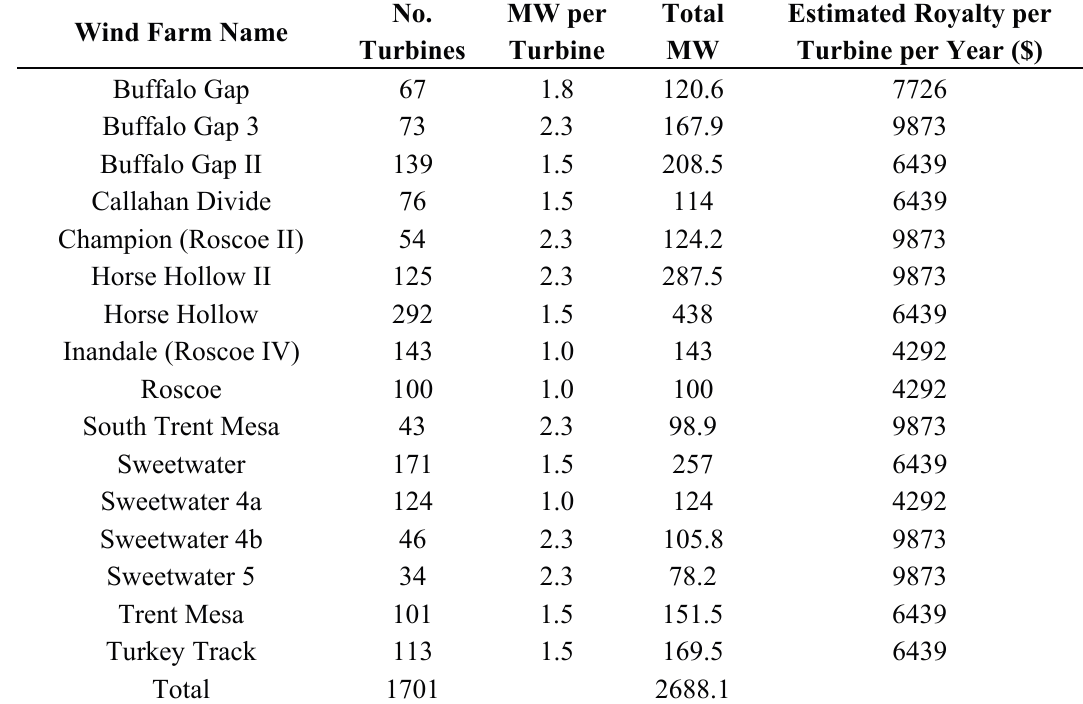
Table 1. Summary of wind farms, capacity, and estimated